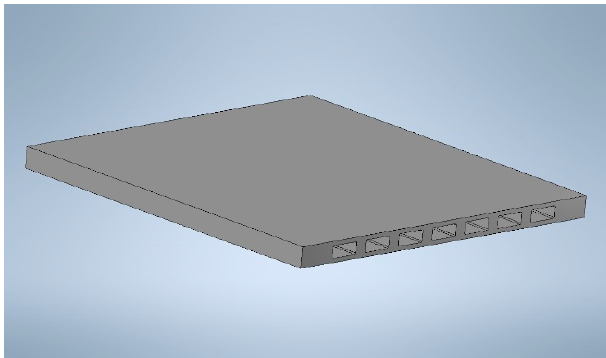
Figure 15. Design of the membrane element with a size of 60 × 60 × ~5 mm 3 .